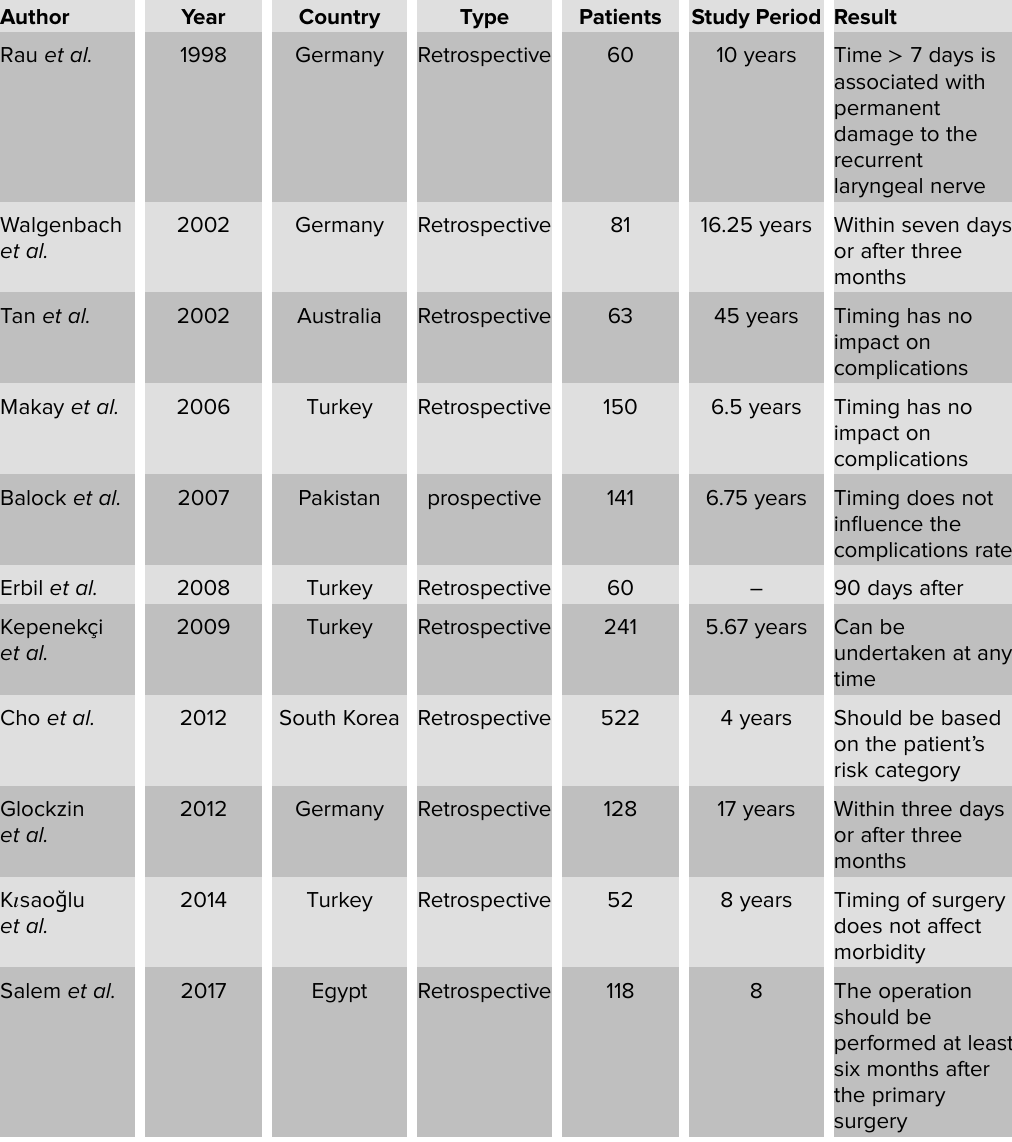
TABLE 2: The timing of completion thyroidectomy and